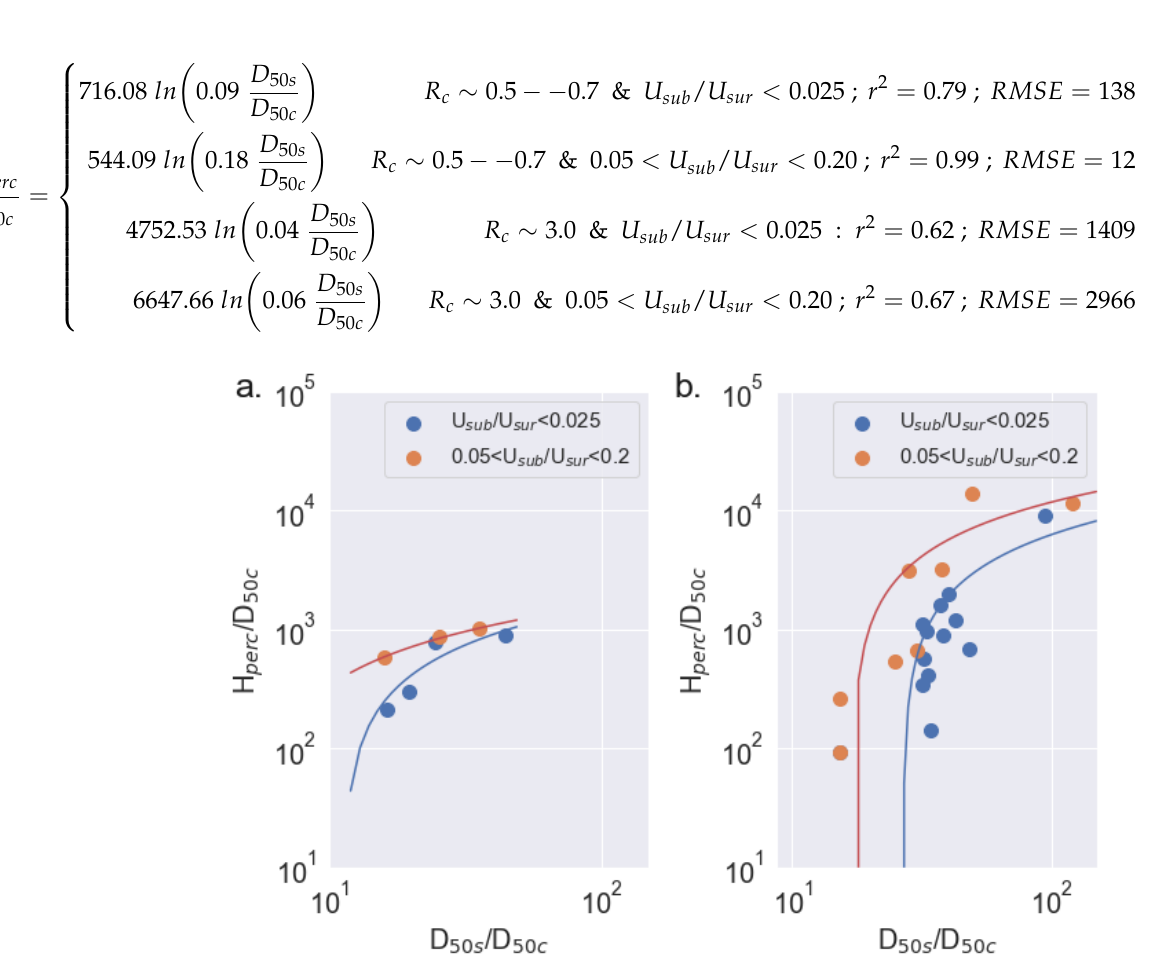
Figure 10. Maximum dimensionless infiltration of fine particles into the substrate as a function of R c , U sub / U sur and ( a ) R c ∼ 0.5–0.7 and ( b ) R c ∼